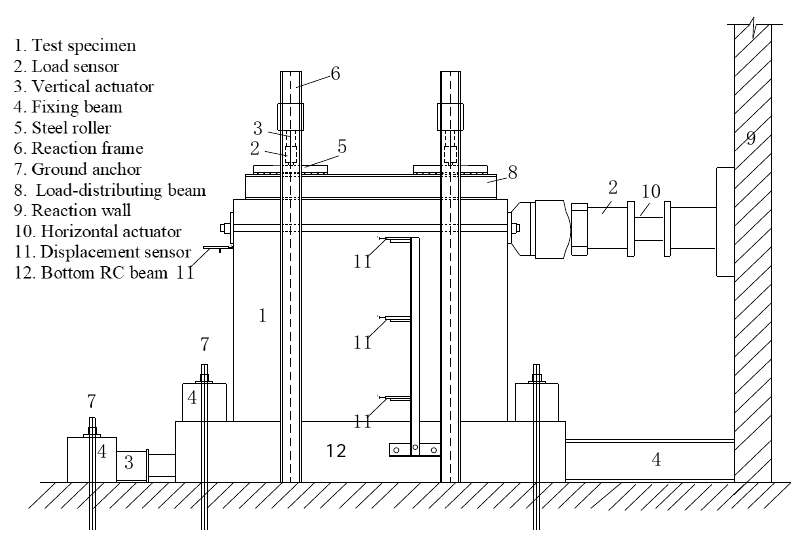
Figure 3. Test setup for in-plane cyclic horizontal load.